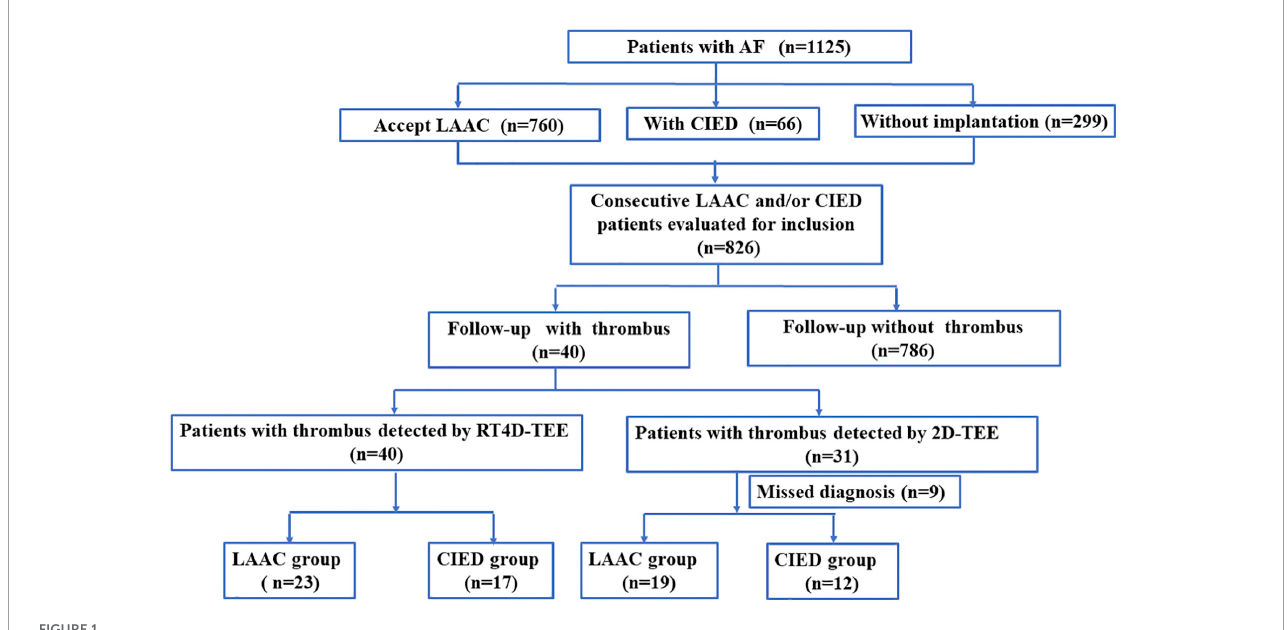
FIGURE1 Flowchart of the study group.